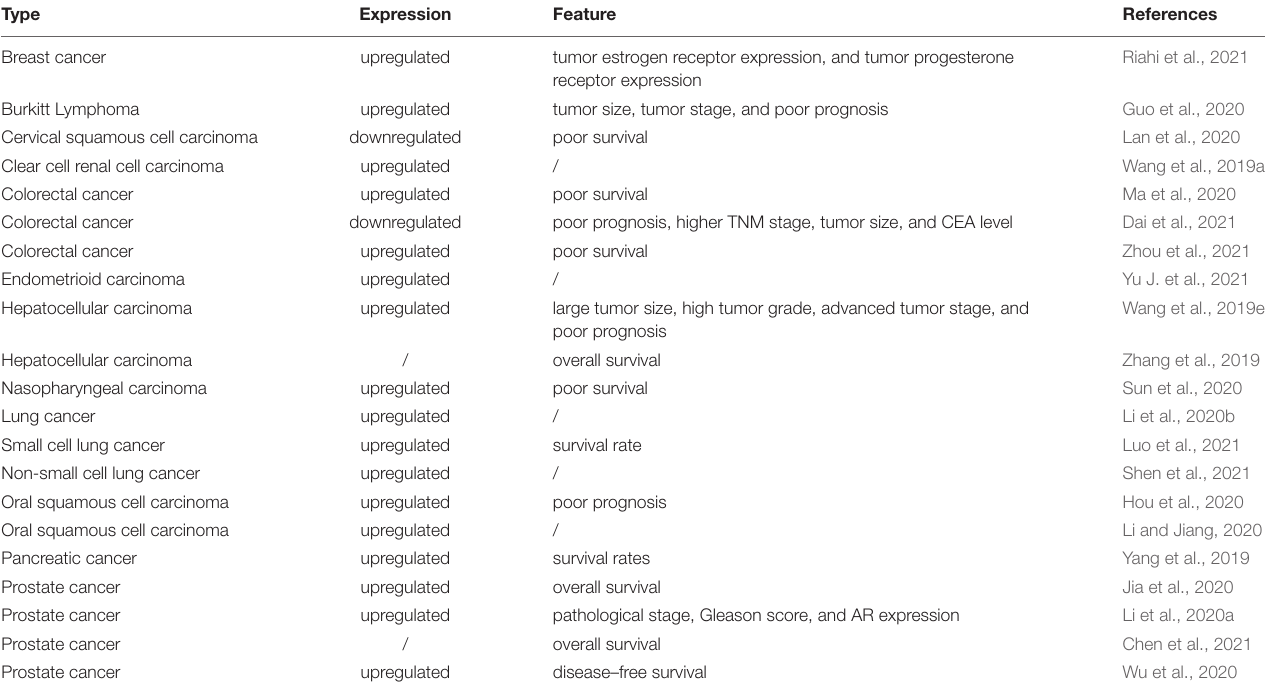
TABLE 1 | Expression and associated clinical features of the lncRNA MCM3AP-AS1 in